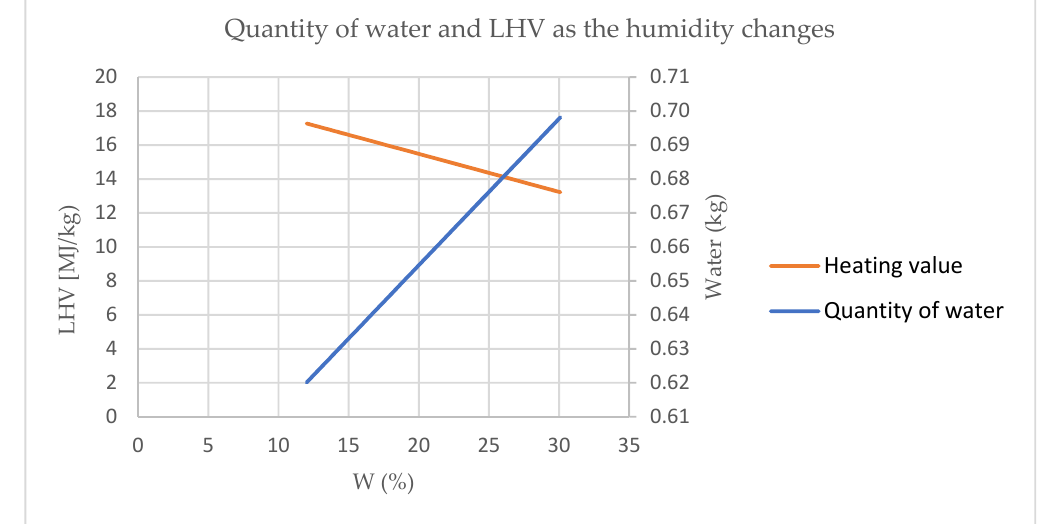
Figure 1. Quantity of water and LHV as the humidity changes. Table 8. Quantity of water and the energy that it represents. Calculations